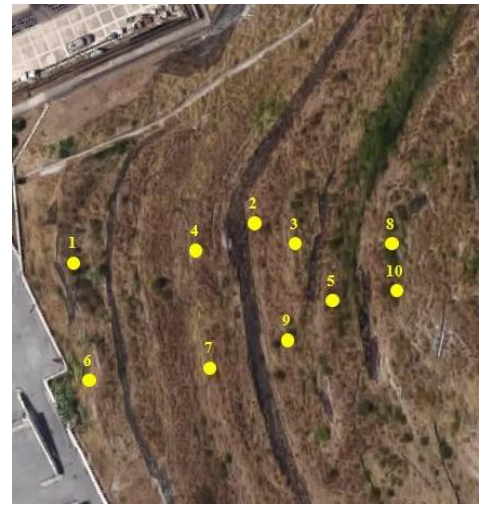
Figure 16. Points detected by GPS